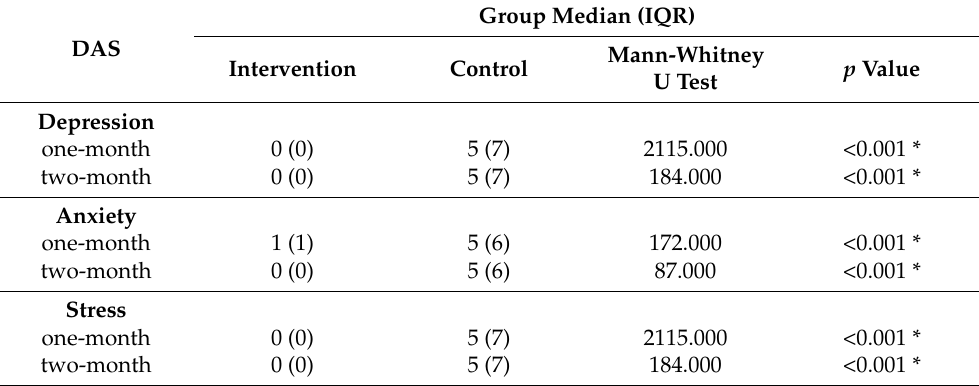
Table 3. Post-intervention comparisons of depression, anxiety, and stress scores between